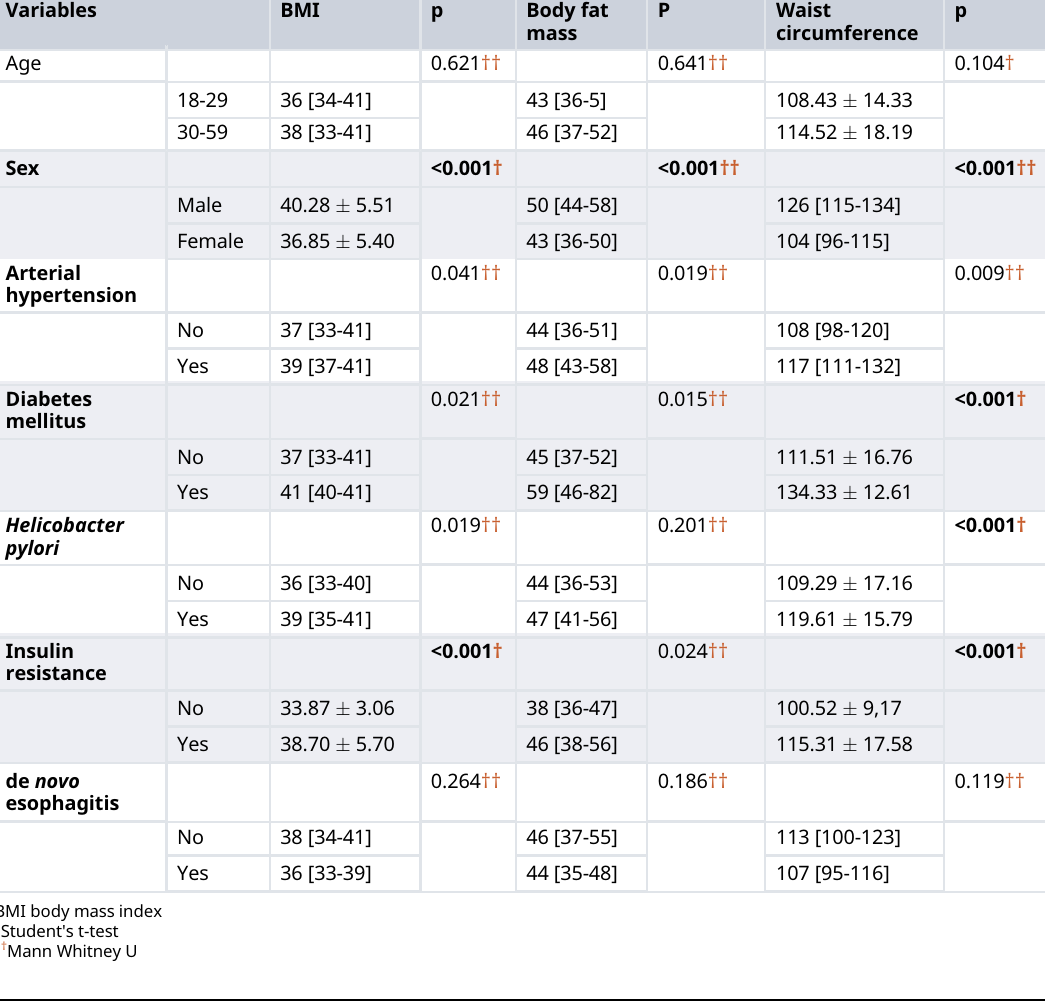
Table 1. Body mass index, body fat percentage and waist circumference according to sociodemographic, comorbidities, presence of Helicobacter pylori , insulin resistance and de novo esophagitis (n=106). Variables